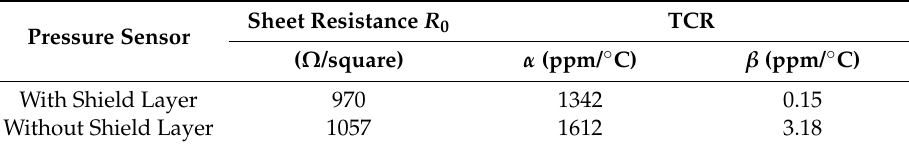
Table 1. TCR computation results by using